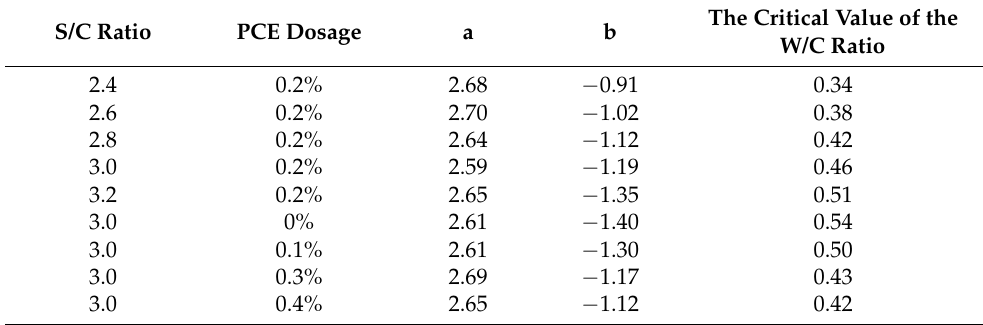
Table 4. Regressed parameters and critical value for the relationship between W/C ratio and